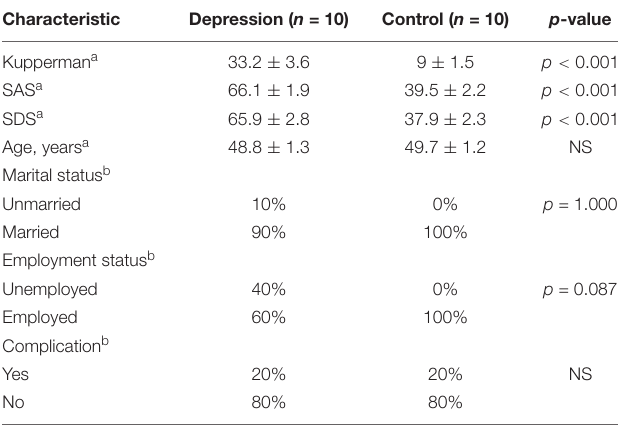
TABLE 1 | Clinical characters of the study